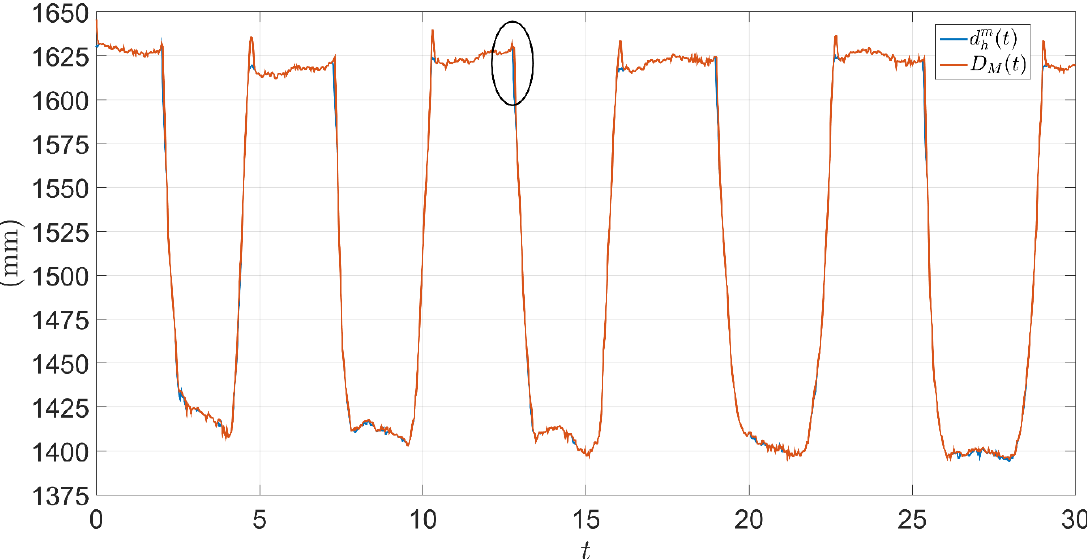
Sensors 2020 , 20 , x FOR PEER REVIEW Figure 8. Signals 𝑑 (cid:3035) (cid:3040) (t) (blue) and 𝐷 (cid:3014) (t) (red) obtained during the one ‐ handed test. Figure 8. Signals d m h (t) (blue) and D M (t) (red) obtained during the one-handed test.